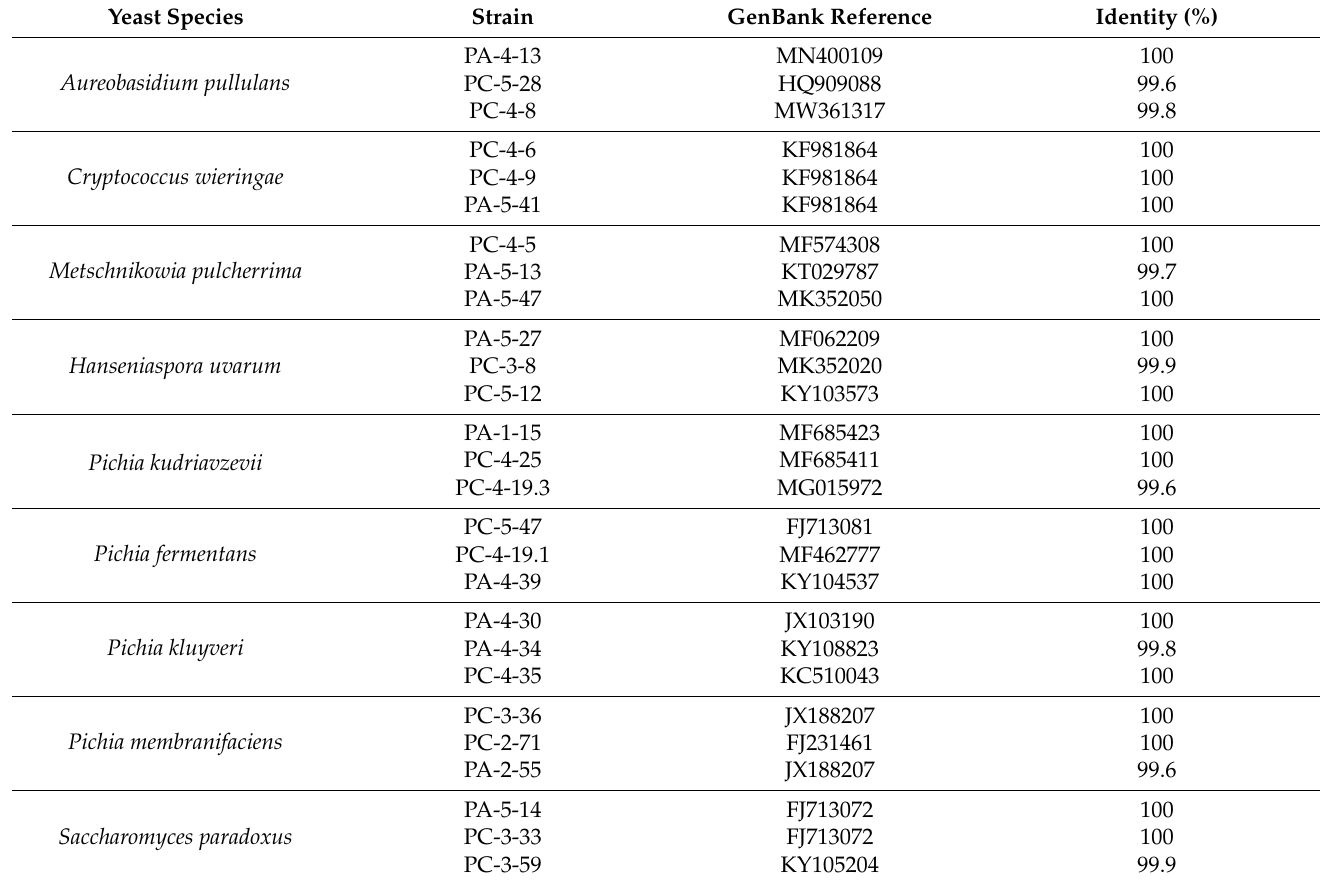
Table A1. List of yeast isolates analysed in this